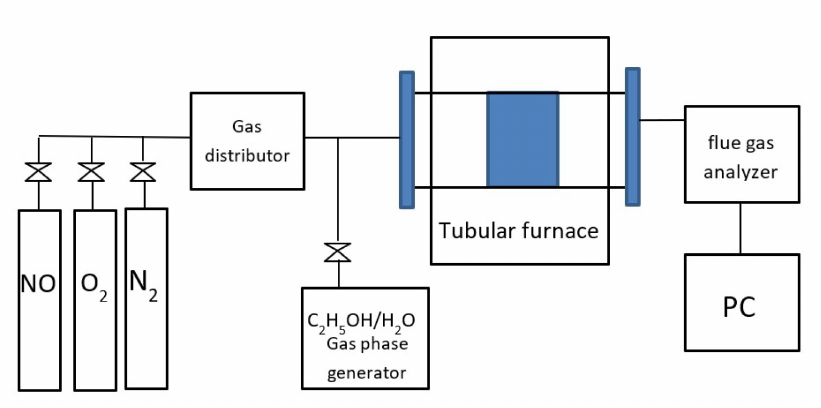
Figure 7. Exhaust purification test system concept